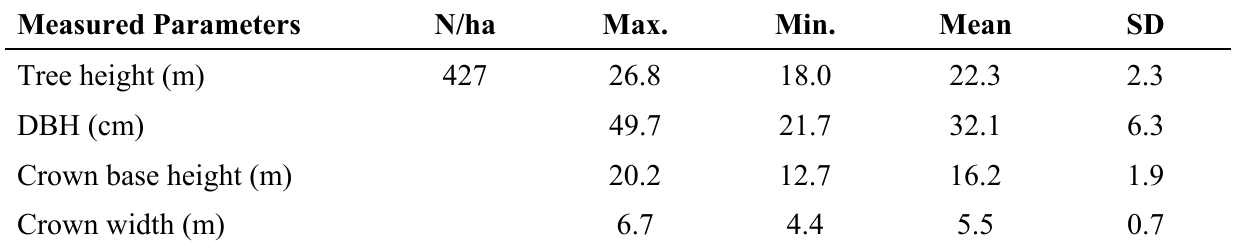
Table 1. Descriptive statistics of the terrestrial laser scanner (TLS) measurements.